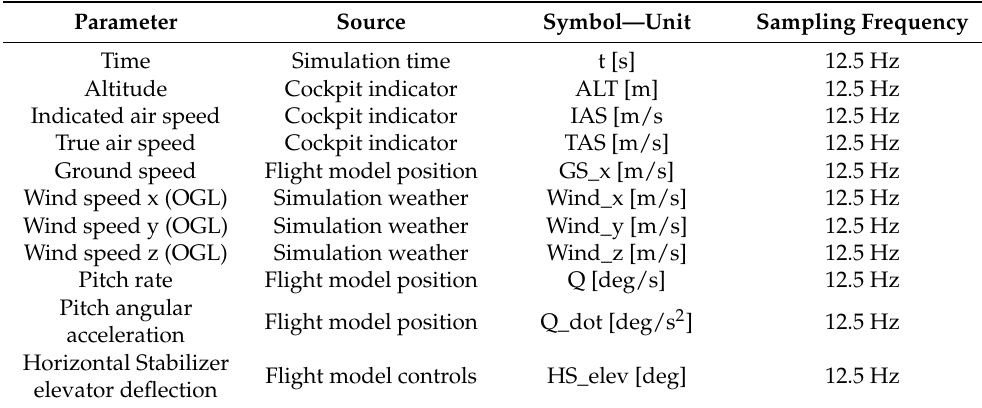
Table 1. Parameters recorded in the X-Plane environment for the purposes of testing the headwind gust estimation algorithm.